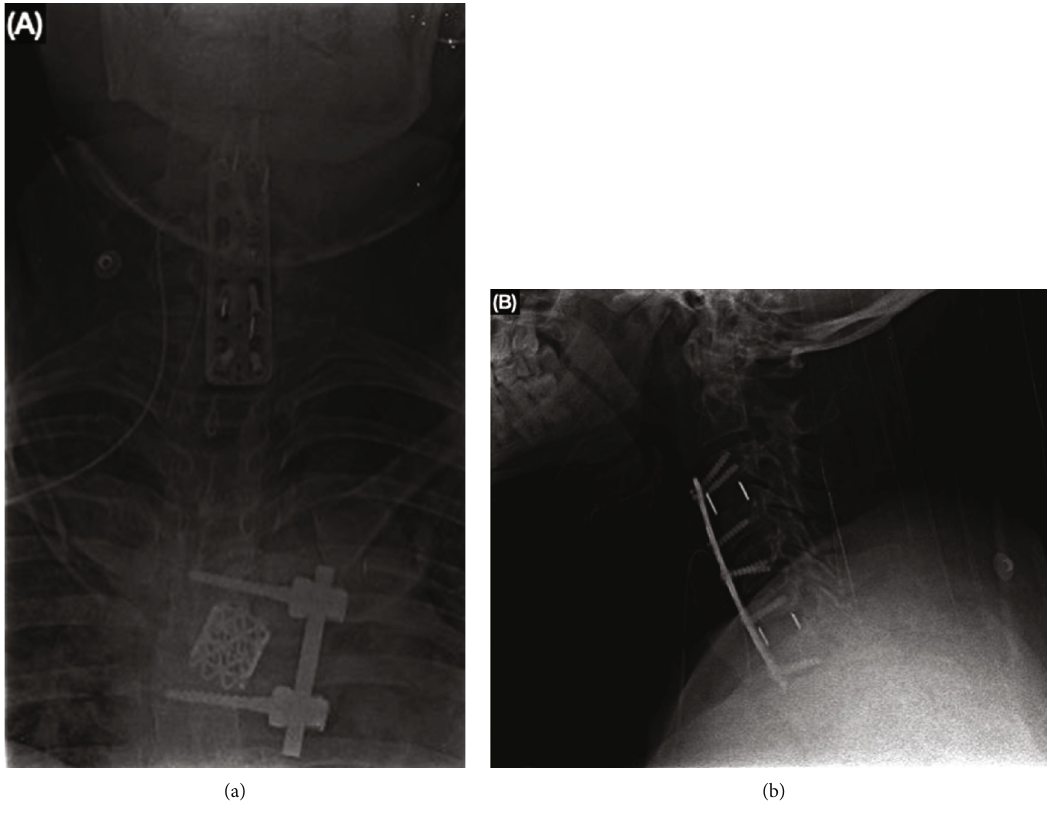
Figure 4: Postoperative x-ray of the cervical spine: (a) surgical material consisting of a 64 mm titanium plate and transcortical locked screws placed from C3 to C7; (b) intersomatic cages at C3-C4 and C6-C7 levels. The amplitude of the intervertebral spaces C2-C3, C4-C5, and C5- C6 is